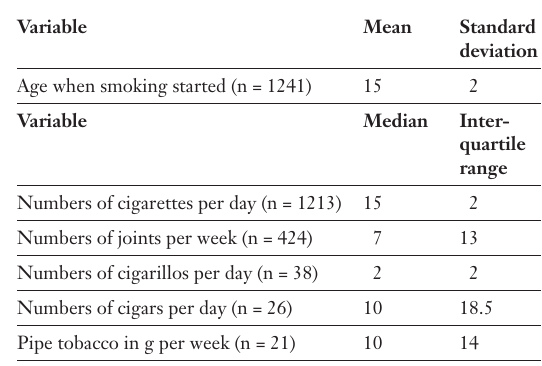
Table 3 Smoking behaviour of Current Smokers (n =